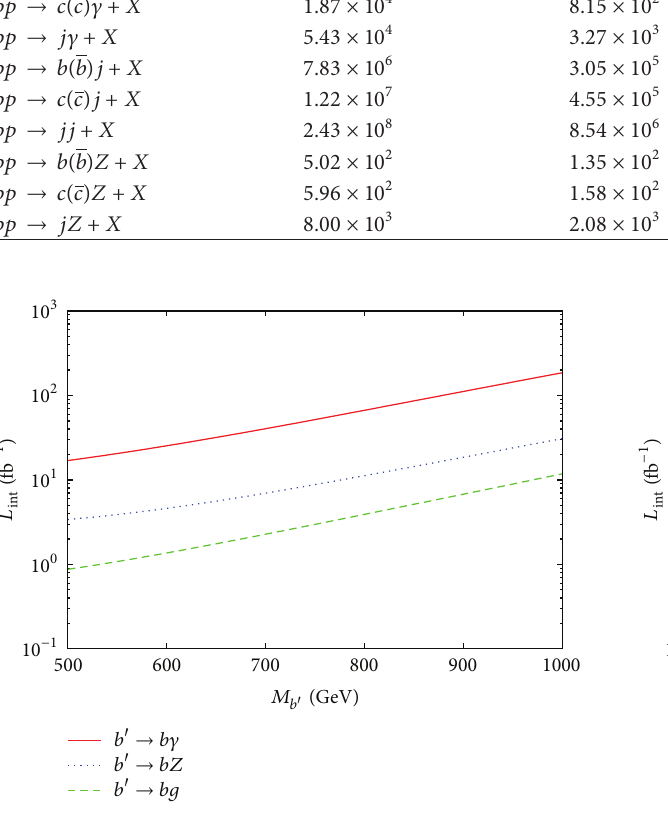
Figure 15: The same as Figure 13, but for parametrization